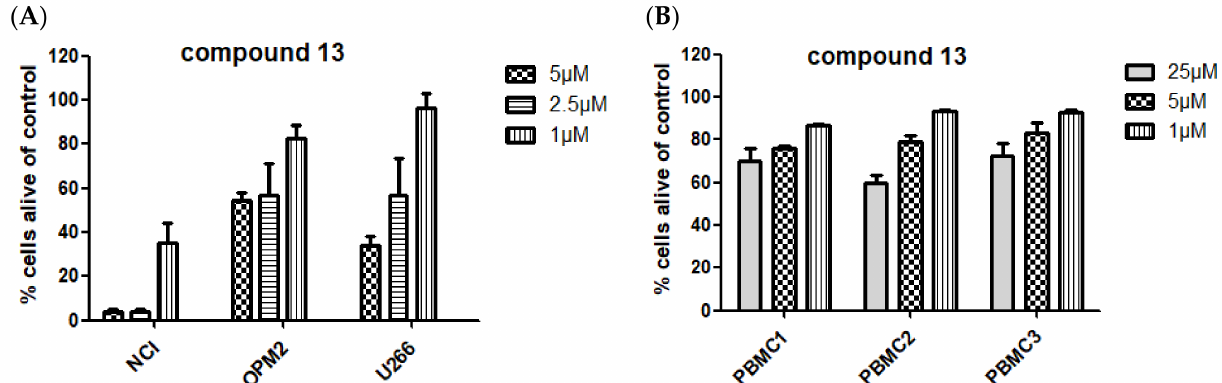
Figure 9. Activity of compound 13 on ( A ) hematological cancer cells (multiple myeloma cell lines) and on ( B ) primary peripheral blood mononuclear cells of three healthy donors (PBMC 1–3). Incubation time was 24 h, followed by flow cytometric